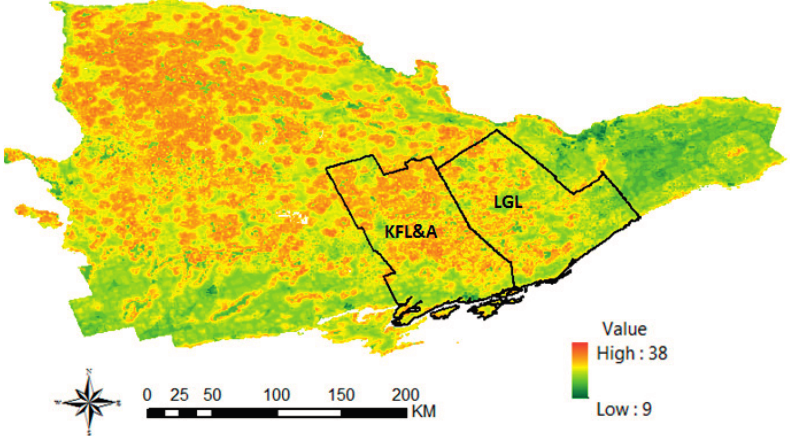
Figure 6. Map of habitat suitability analysis results from the rank sum weighting